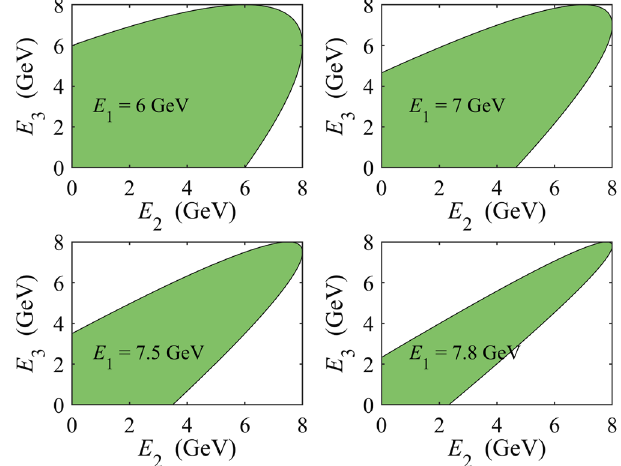
FIG. 8. Tunable energy range of E 2 and E 3 (colored area) when the first beam energy E 1 ¼ 6 = 7 = 7 . 5 = 7 . 8 GeV, initial beam energy E 0 ¼ 4 GeV and the on-crest energy gain of the linac for off-frequency detune is limited to be 4 GeV.